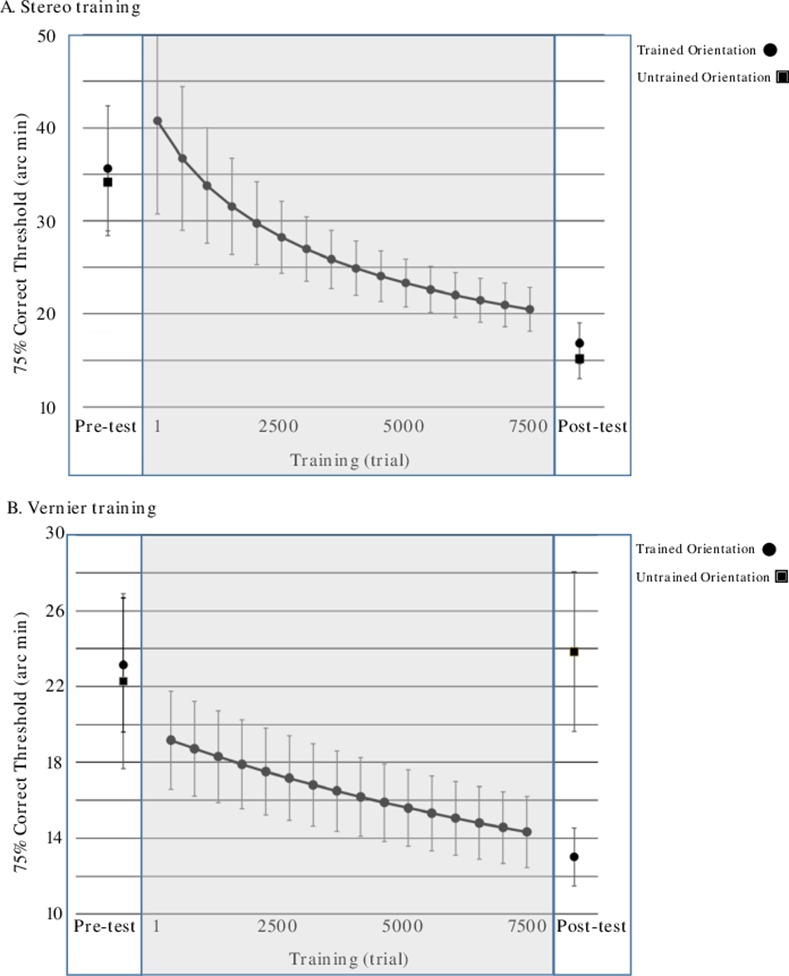
Raw performance on the trained task.
A) Stereo training: Participants showed roughly equivalent performance on the two possible stimulus orientations before training commenced (“pre-test”). They then showed clear learning throughout the 7500 trials of training (“training”–gray region). And at post-test, they showed roughly equivalent improvements on the two possible stimulus orientations after training (“post test”). Consistent with our hypothesis, this suggests significant orientation transfer in the stereo trained group–a pattern that is quantified below (see Results/Fig 4). B) Vernier training: Participants showed equivalent performance on the two possible stimulus orientations before training commenced (“pre-test”). They then showed clear learning throughout the 7500 trials of training (“training”–gray region). However, during post-test, while they showed clear improvement on the trained orientation, there was little evidence of learning on the untrained orientation (“post test”). This suggests significant orientation specificity–a pattern that is quantified below (see Results/Fig 4). *Error bars denote s.e.m.